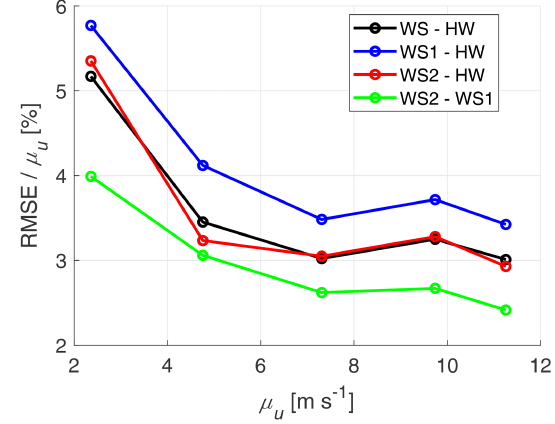
Figure 19. Normalised root-mean-square error of the measured wind speed with respect to the hot-wire anemometer for each of the five cases at